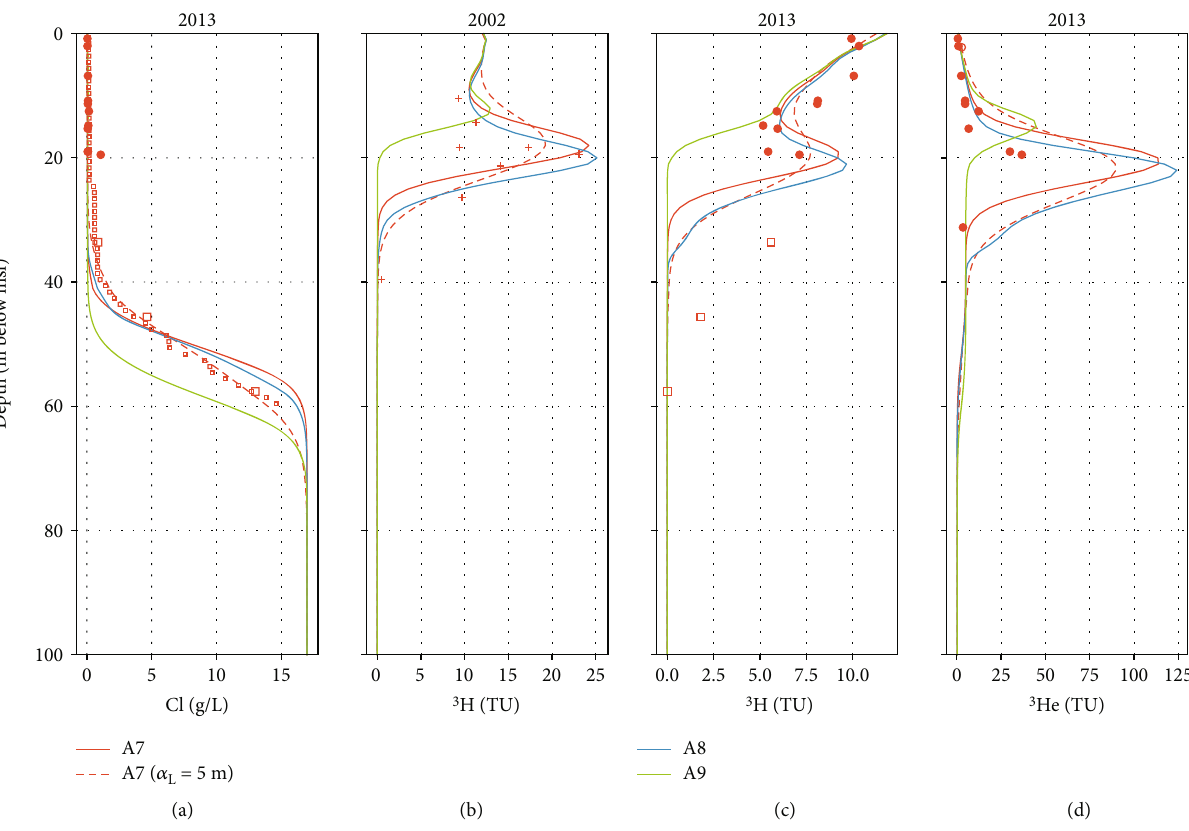
Figure 3: (a) Chloride concentration, (b, c) 3 H concentration, and (d) 3 He concentration as a function of depth for observation well 17. The small red square marker symbols in (a) indicate the chloride concentration calculated from the downhole σ 25 log. Round symbol markers in (a), (c), and (d) represent samples collected in 2013 (previously published by Houben et al. [7]); square symbol markers are for the samples from well 17. Crosshair symbols in (b) are data for January 2002 from Marggraf [30]. The displayed samples are from di ff erent wells within 300 m of the model cross section. The solid lines represent the model outcomes (discussed later on) of simulations A7-A9; the dashed lines are for simulation A7 with longitudinal dispersivity α L = 5m . See Figure 1(b) for the location of observation well 17 and Figure 10 for its projected location on the modelled cross section.